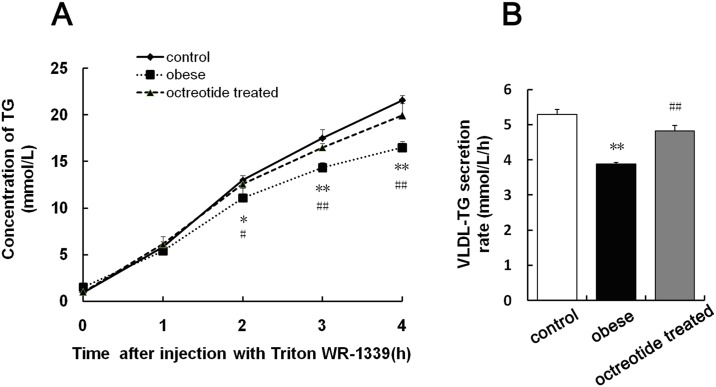
Hepatic secretion of VLDL-triglycerides in fasting rats after i.v. administration of Triton WR-1339.Three groups of rats (control, obese and octreotide-treated group) were fasted for 12 hours prior to tail intravenous injection of Triton WR1339 at 500 mg/kg body weight. Blood samples were taken at 0, 1, 2, 3, and 4 hours post-injection for the estimation of plasma TG concentrations (A). The VLDL secretion rates (mmol/L/h) were calculated using the slopes of the curves (B). Data are presented as the mean ± SD (n = 3). *p<0.05 vs. control group; **p<0.01 vs. control group; #p<0.05 vs. obese group; ##p<0.01 vs. obese group.